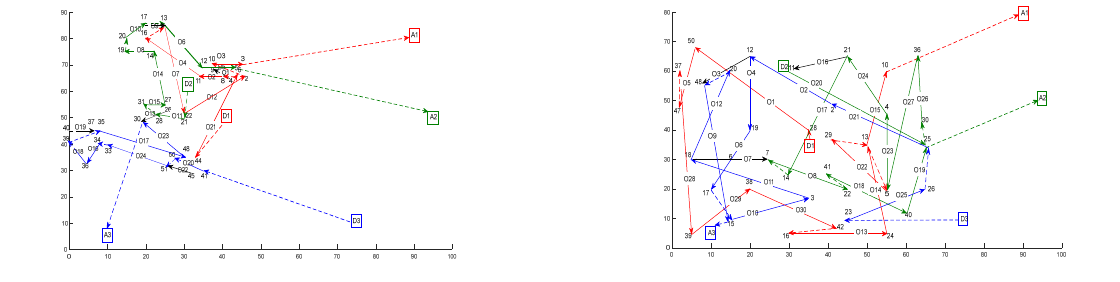
Fig. 4. Result for instance 𝑺𝑭𝑻𝑳𝟓 / 𝑪𝟓𝟎 / 𝟐𝟒 / 𝟑 Fig. 5. Result for instance 𝑺𝑭𝑻𝑳𝟓 / 𝑹𝟓𝟎 / 𝟑𝟎 / 𝟑